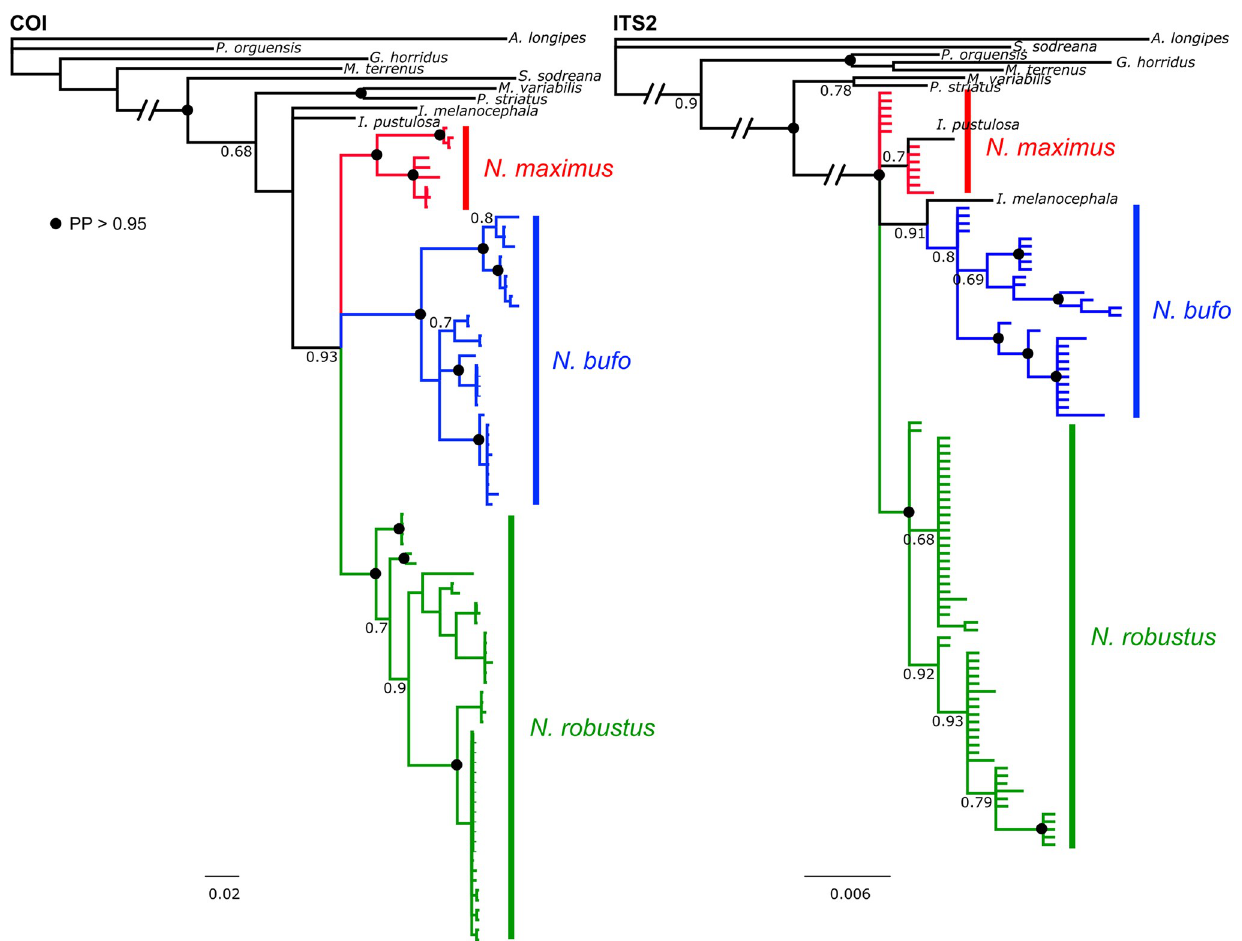
Fig 12. Topologies recovered under Bayesian inference analyses with MrBayes. On the left, topology inferred for COI sequences; on the right, for ITS2 sequences. In the nodes, the posterior probability values; black circles represent posterior probability > 0.95.